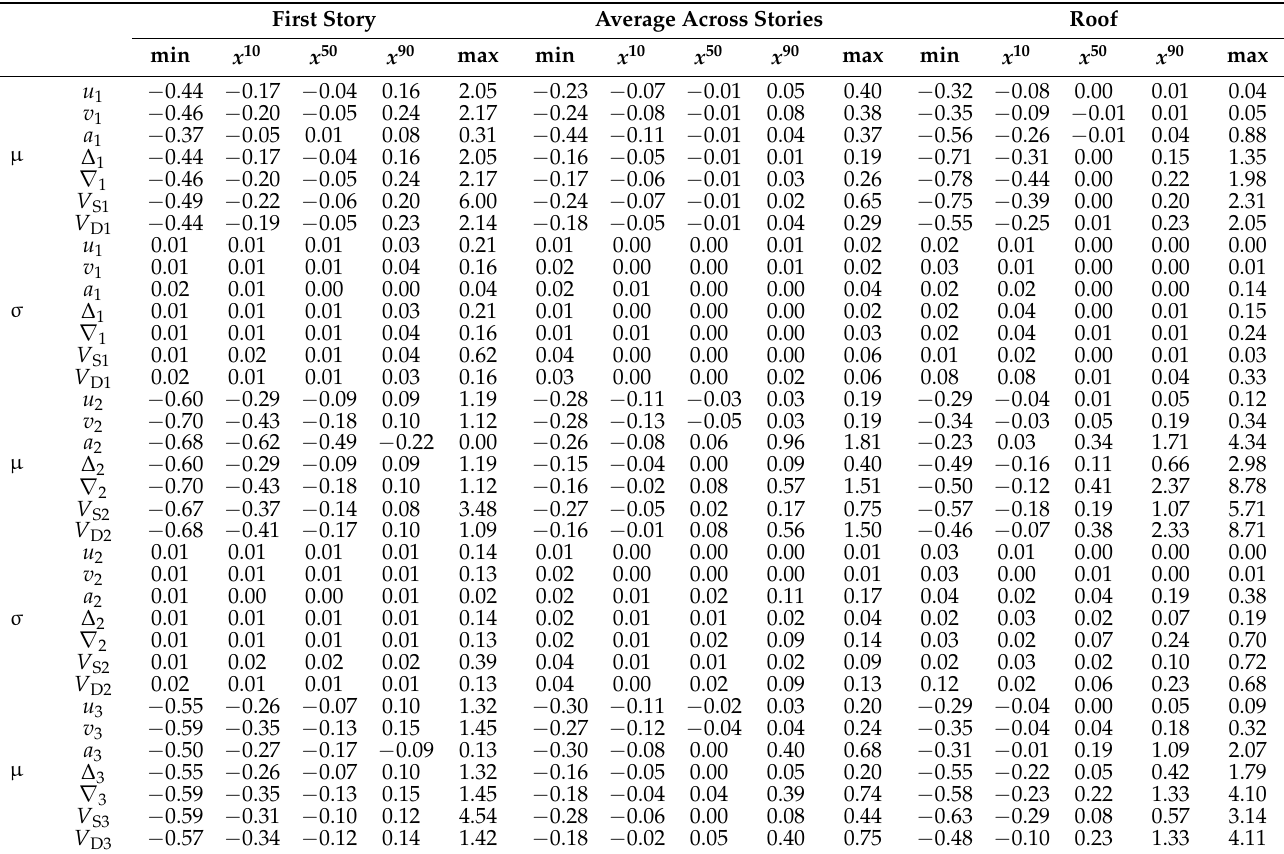
Table 2. Frame-type cases (B0-1, B3-1, B5-1, C3-1, B3-0.5, B3-2), mean µ and standard deviation σ of error across